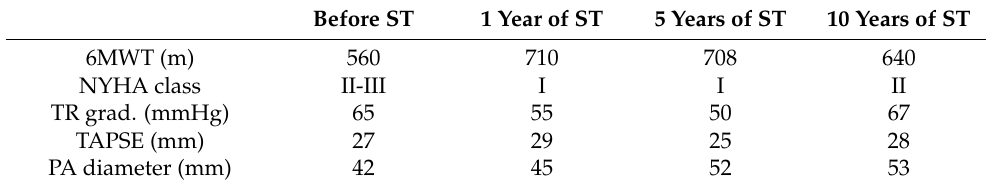
Table 4. Functional and echocardiographic parameters during the follow-up period (Patient 2).